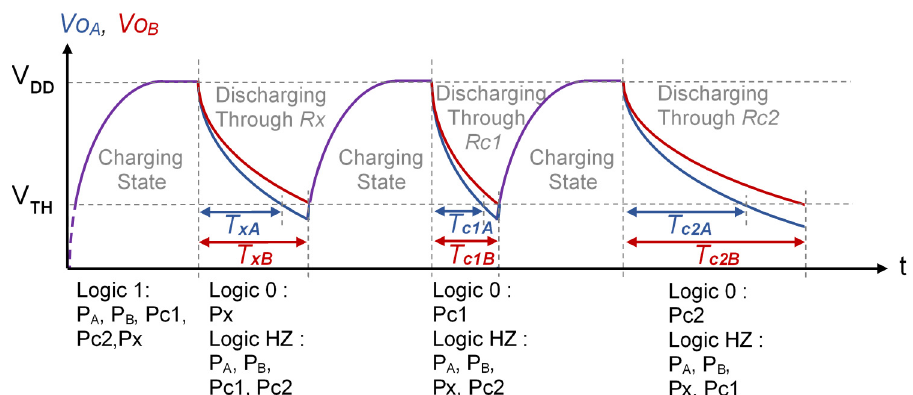
Figure 4. Steps necessary for the operation of the TCDIC shown in Figure 3. The time is measured in node A and another time is measured in node B in each discharge stage. Thus, we have T xA , T xB , T c1A , T c1B , T c2A , and T c2B , which will then be used to estimate Rx .